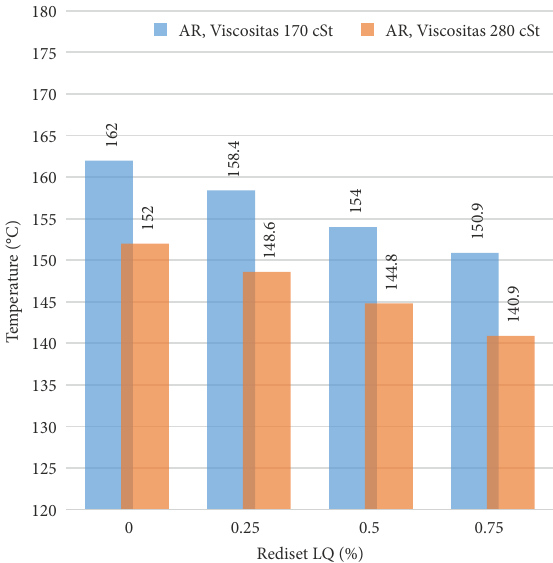
Figure 6. Temperature at viscosity of 170 cSt and 280 cSt of PVLNR modified asphalt in variant percent of Rediset LQ